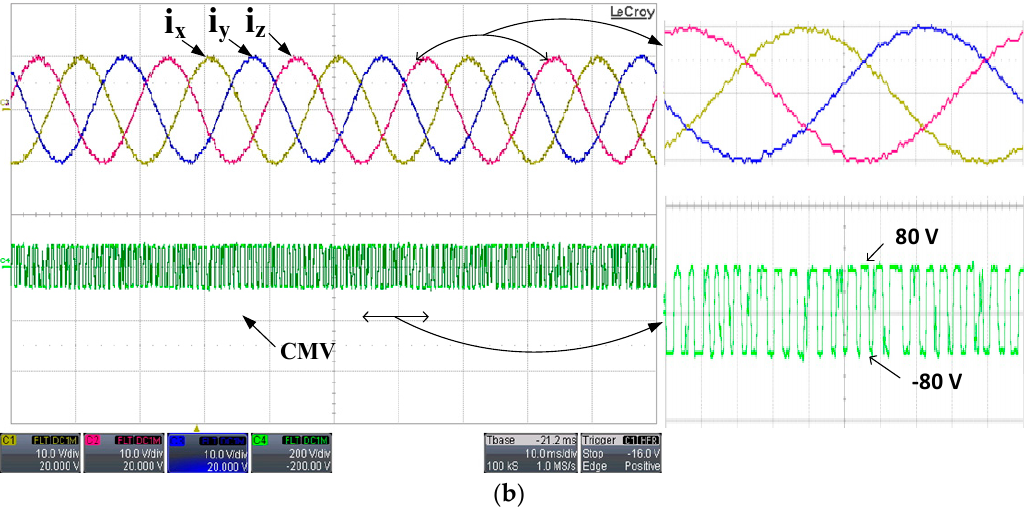
Figure 7. Each phase current and CMV for Case 3 ( a ) Simulation result, ( b ) Experimental result ( I = 10 A/div., CMV = 200 V/div. and 10 ms/div.).